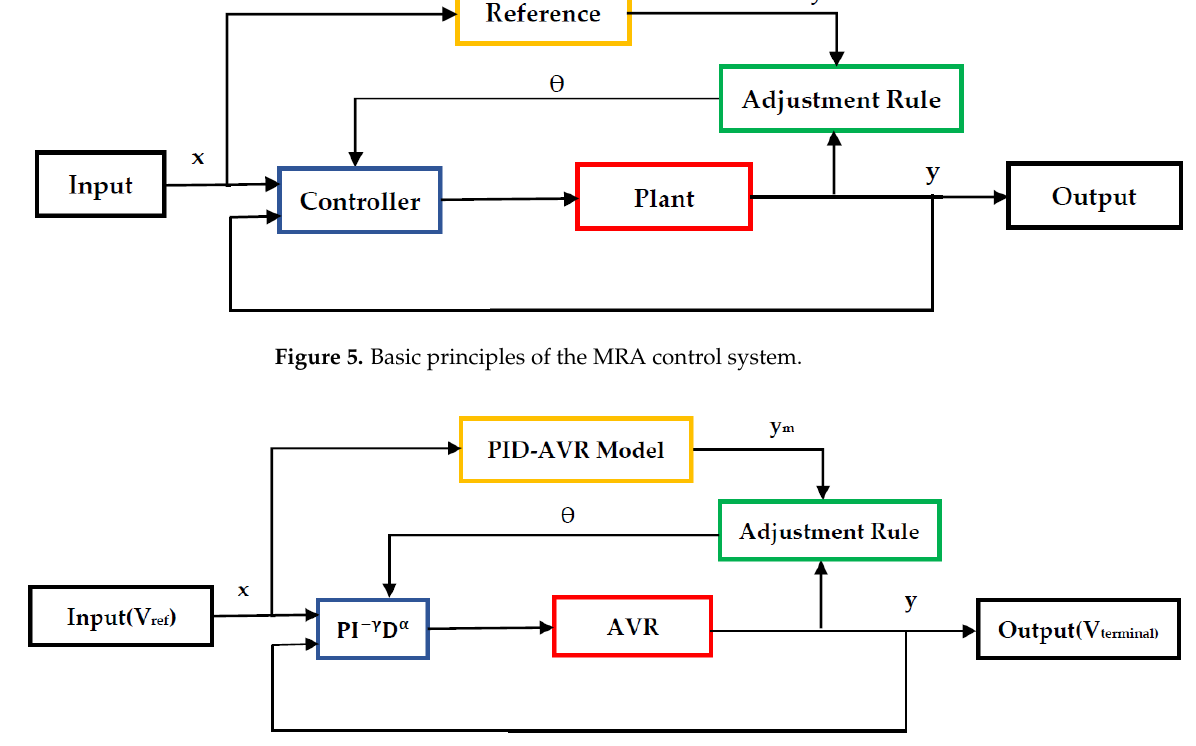
Figure 6. Basic principles of the proposed OPIDMR-FA control system.